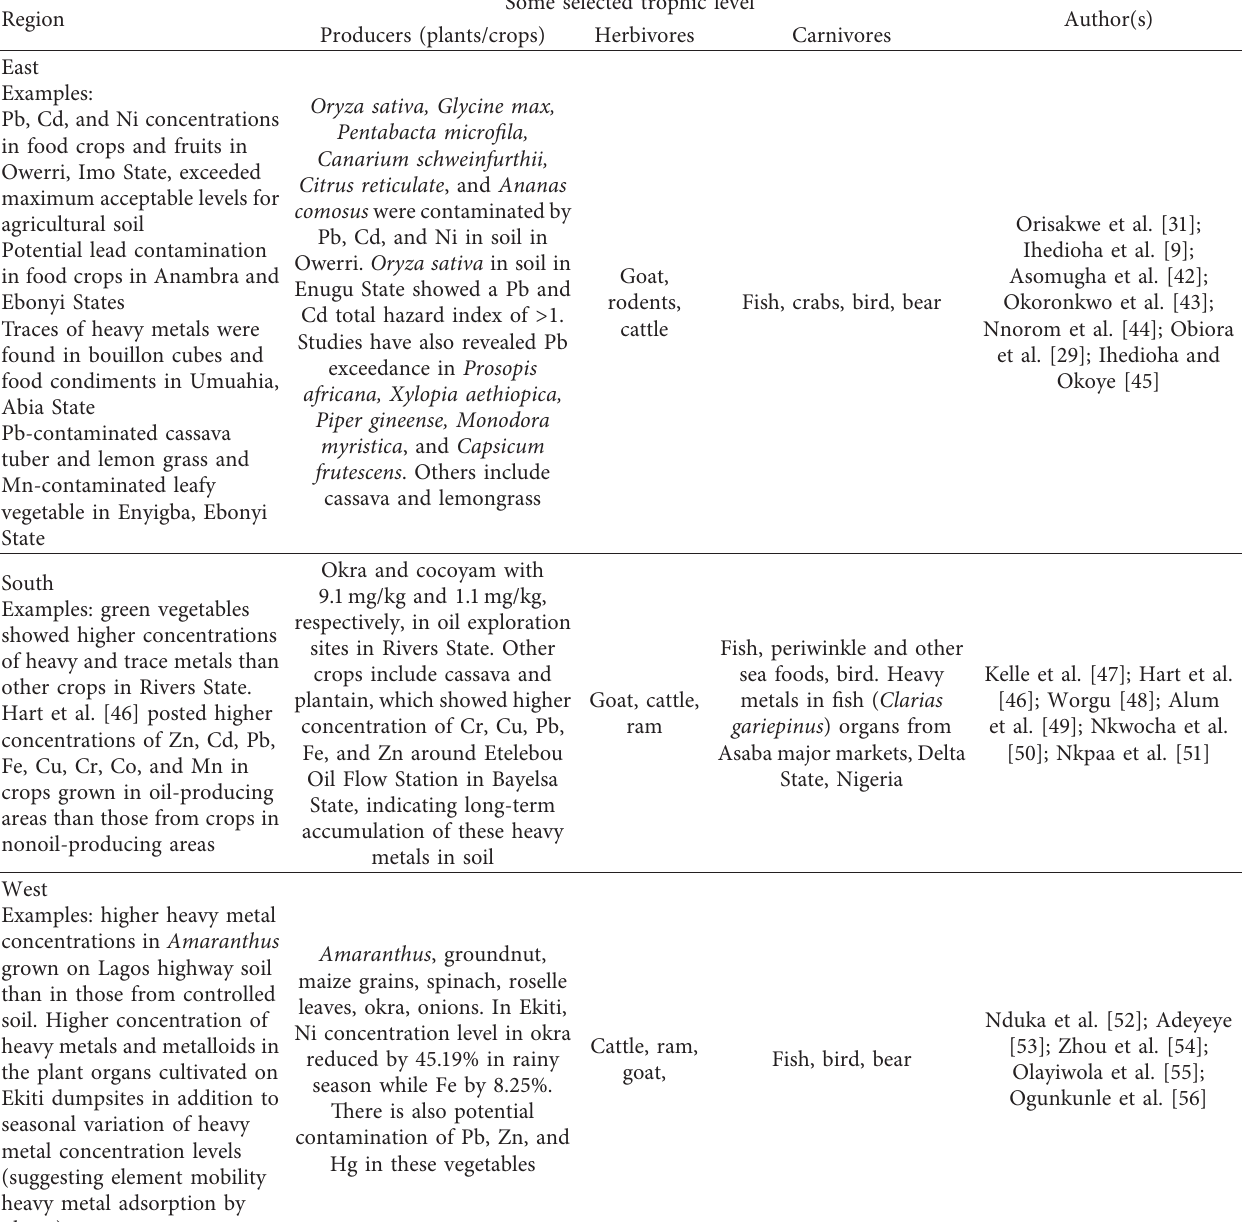
Table 1: Regional environmental contamination of some selected trophic levels in Nigeria.